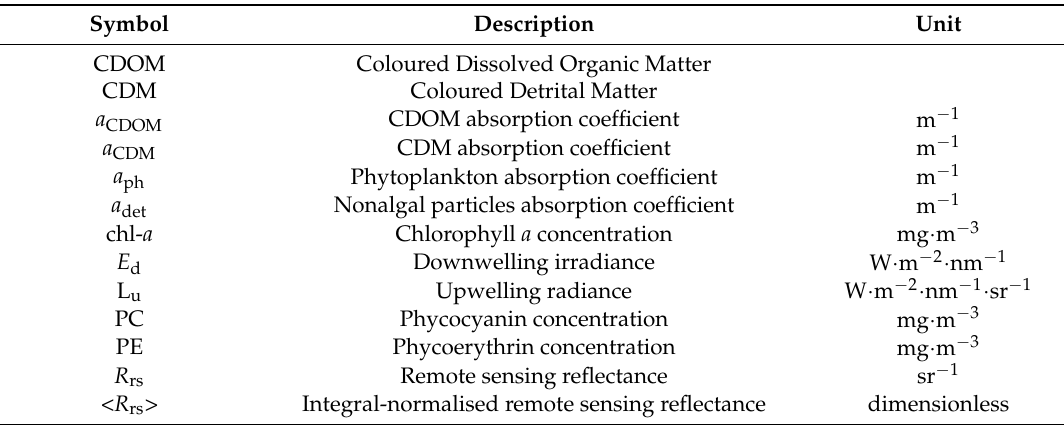
Table 1. List of symbols, definitions, and